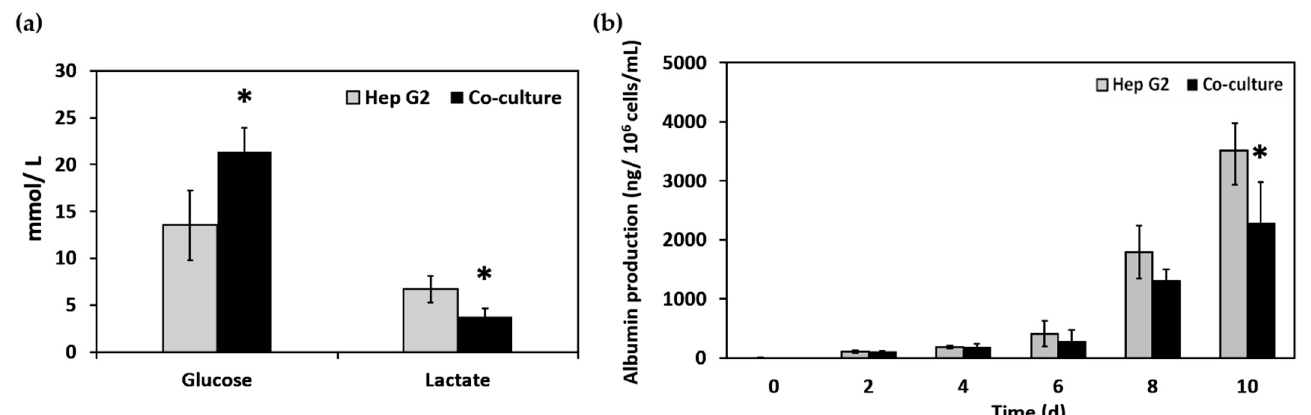
Figure 5. ( a ) Glucose consumption and lactate production of pure culture Hep G2 and co-culture Hep G2/HUVEC under perfusion culture system at day 10; ( b ) albumin production between Hep G2 and co-culture Hep G2/HUVECs showed significant different with P < 0.05 indicated by * at day 10. Each column represents the mean ± SD ( n = 3 independent experiments), * P < 0.05.